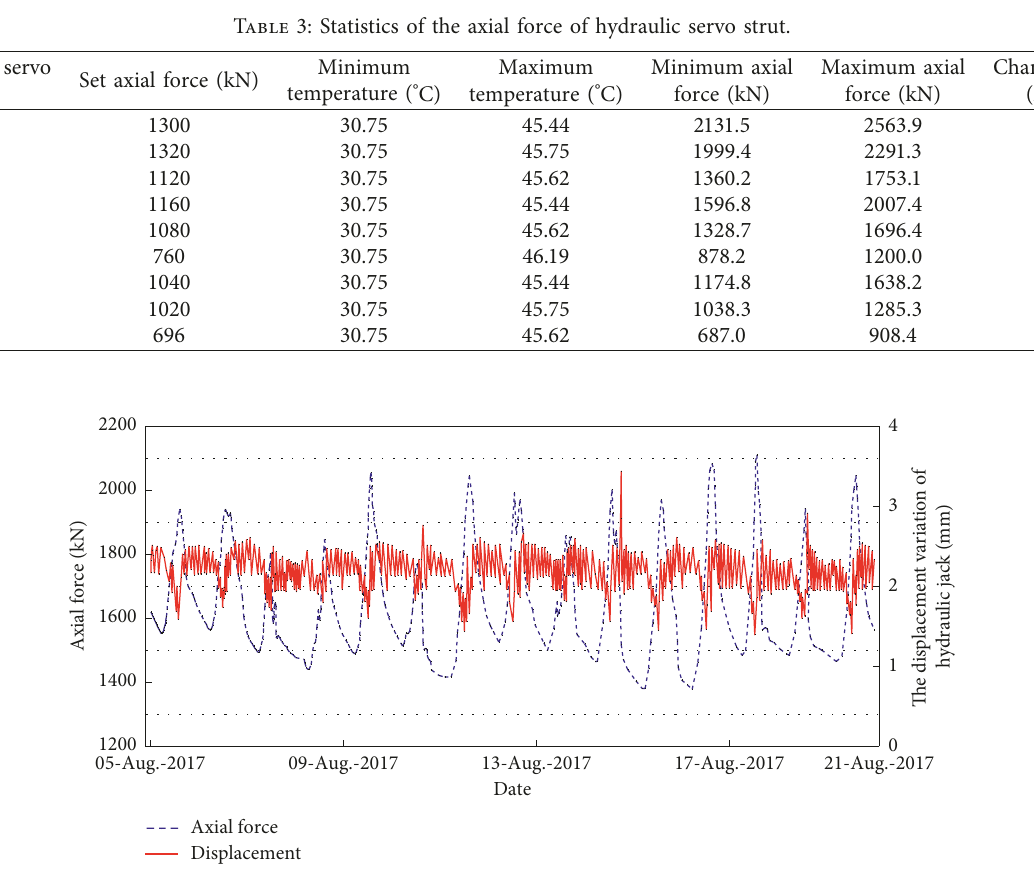
Figure 18: Trend of the axial force and displacement variation in the hydraulic servo steel struts.